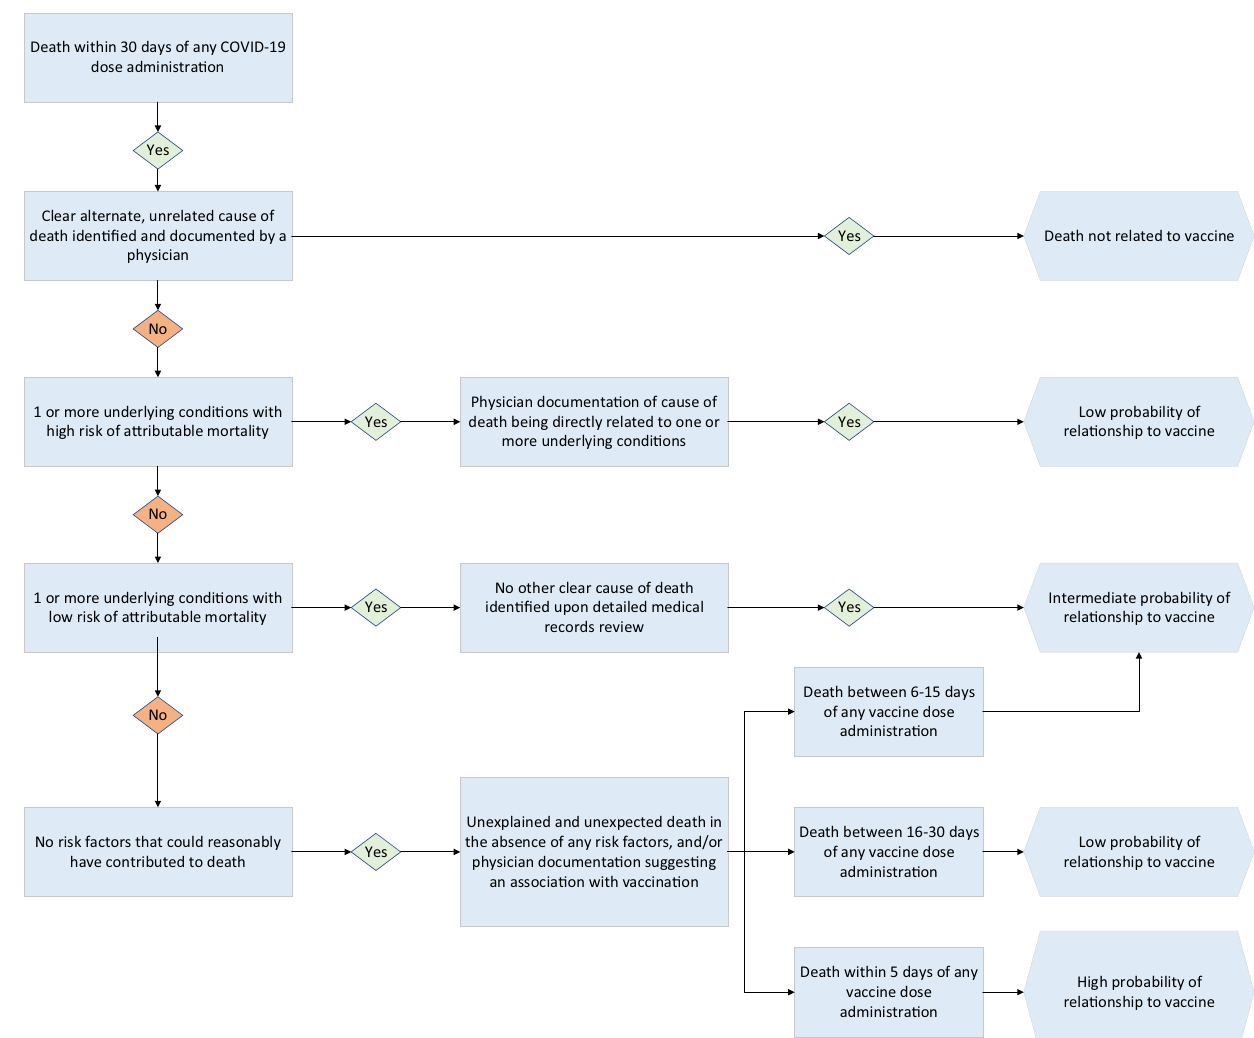
Fig. 2 | Study fl ow sheet demonstrating the individuals included in the analysis and the numbers of deaths with the probability of their relationship to SARS-CoV-2